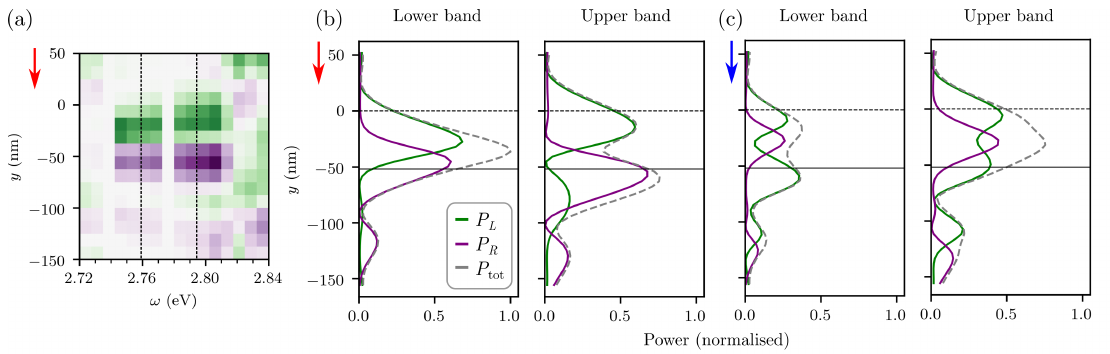
Figure A6. Far field excitations: ( a ) P ∆ = P L − P R for the red path in Figure 4b and frequencies across the band gap. ( b ) Directionality along the red path: Power through the edge P tot , left P L and right channels P R for lower and upper bands. (The lower and upper band line plots are equivalent to the vertical lines in ( a ).) ( c ) Directionality along the blue